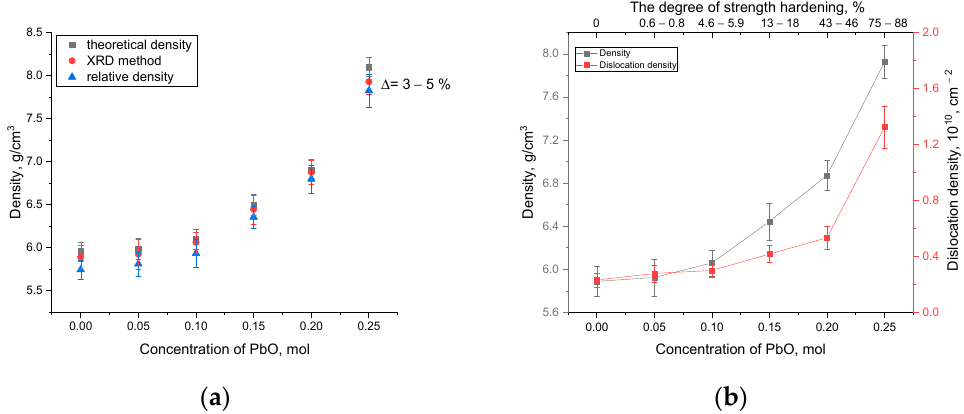
Figure 11. ( a ) The results of variations in the density of ceramics depending on the PbO dopant concentration; ( b ) Results of variations in density and dislocation density depending on the PbO dopant concentration.